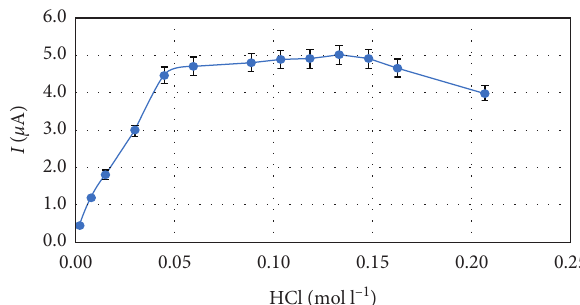
Figure 5: Influence of HCl concentration on the I 0.1mg l − 1 Hg 2+ , sweep rate 0.04V s − 1 , pulse amplitude 0.05V, and pulse time 0.04s.